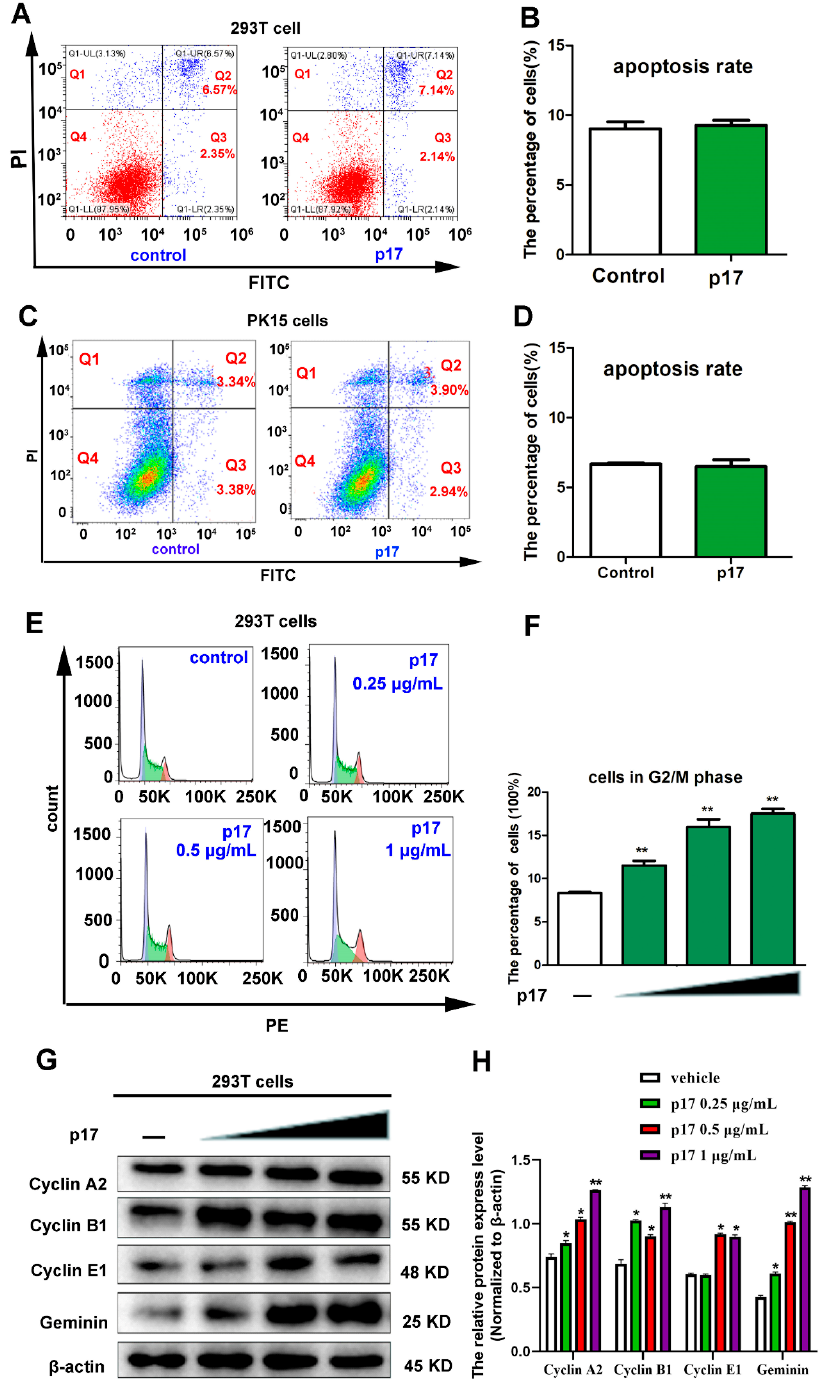
Figure 2. Effects of p17 on cell apoptosis and cell cycle progression. ( A – D ) The effects of p17 on cell apoptosis in 293T and PK15 cells. The effects of p17 on cell apoptosis were analyzed using Annexin V-FITC/PI staining followed by flow cytometry. Control groups were transfected with empty plasmid for 24 h. P17 groups were transfected with FLAG-p17 plasmid (1 µ g/mL) for 24 h. ( E , F ) The effect of p17 on cell cycle distribution in 293T cells. The cell cycle distribution was analyzed using PI/RNase staining followed by flow cytometry. Control groups were transfected with empty plasmid for 24 h. The FLAG-p17 plasmids for transfection were 0.25, 0.5, and 1 µ g/mL, respectively, for 24 h. ( G ) Effect of p17 on the expressions of cell cycle regulatory proteins, including Cyclin A2, Cyclin B1, Cyclin E1, and Geminin. The FLAG-p17 plasmids for transfection were 0.25, 0.5, and 1 µ g/mL for 24 h, respectively. ( H ) The intensity of the western blot bands was quantified by densitometric analysis. Values represent the mean ± S.D; * p < 0.05, ** p < 0.01 versus the control